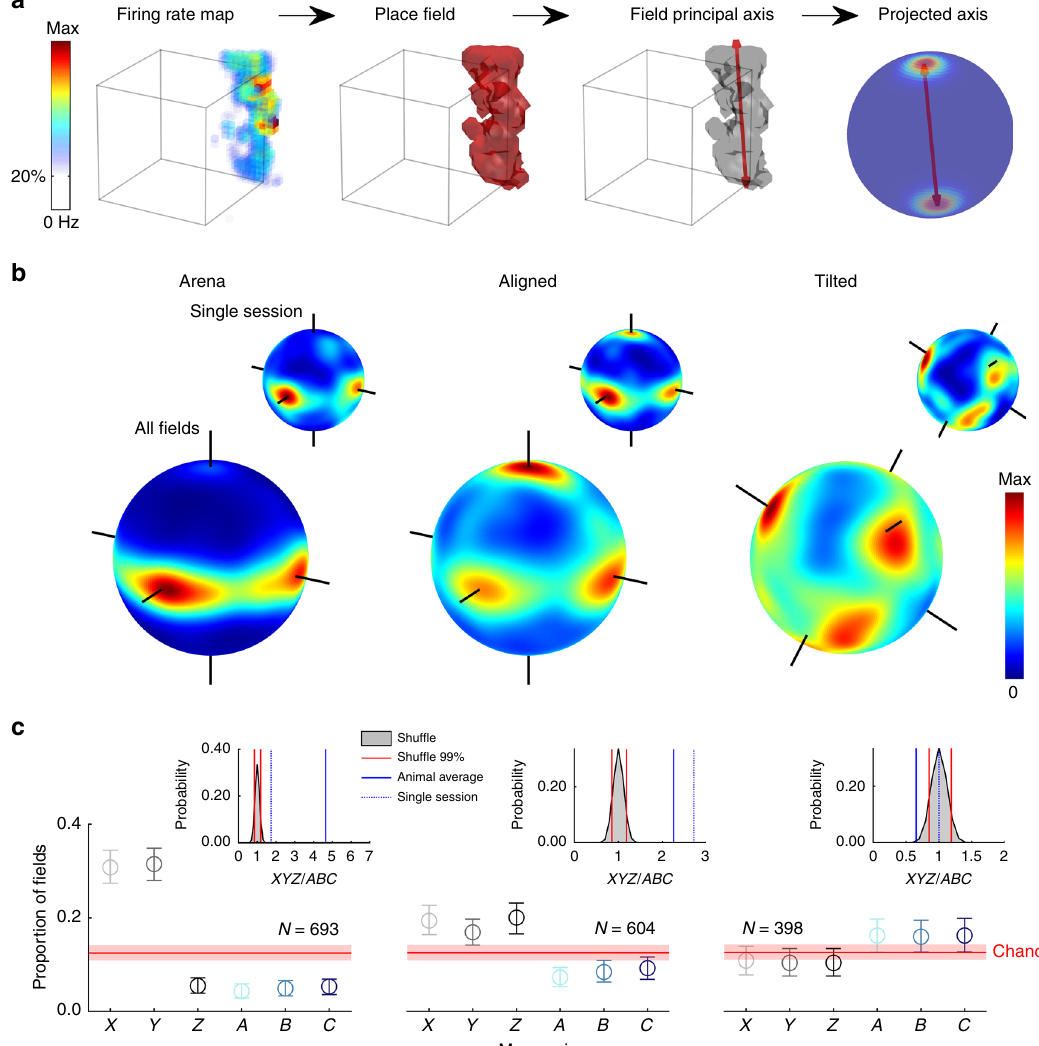
Fig. 7 Place fi elds were oriented parallel to the maze axes. Source data are provided as a Source Data fi le. a Schematic showing how the orientation of place fi elds was extracted and visualized. A place fi eld is detected in an example fi ring rate map through thresholding, the principal or longest axis of this fi eld can then be extracted (red arrows, third plot). To visualize the orientation of multiple fi elds we project these axes onto a unit sphere and generate a spherical Von-Mises kernel smoothed density map, where hot colors denote that many fi elds ‘ pointed ’ their principal axis in this orientation. b Three- dimensional heat plots of place fi eld orientation for the three maze con fi gurations; inset heat plots (top right) show data for a single session, large plots (bottom) show data for all place fi elds. Note concentration around the three axes of the aligned and tilted mazes. Flat cylindrical projections can be seen in Supplementary Fig. 8. c Graphs show proportion of total fi elds oriented roughly parallel to each possible maze axis. Circles give the observed proportion per axis, error bars represent 95% con fi dence intervals calculated through a bootstrapping procedure. Red lines show the 50th percentile of a shuf fl e distribution while shaded red areas denote the interval between the 2.5th and 97.5th percentiles. Inset plots show the result of a shuf fl e testing the probability of observing this ratio of total XYZ fi elds to total ABC fi elds by chance. Red lines denote the 1st and 99th percentile rank positions in the shuf fl ed distribution of ratio values (gray area), blue line denotes the overall ratio value averaged across rats, and blue dotted line denotes the ratio value observed in the single session shown in c